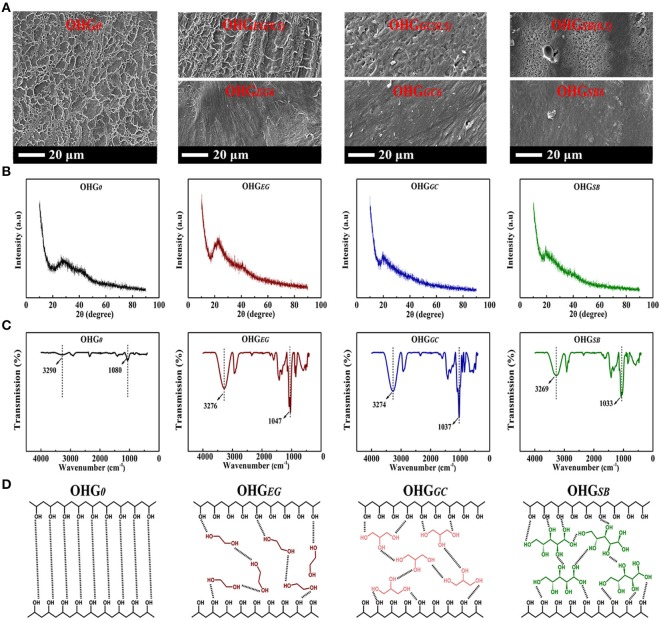
(A) SEM images of the gels [OHG0, OHGEG(0.5), OHGGC(0.5), OHGSB(0.5), OHGEG6, OHGGC6, OHGSB6], (B) XRD patterns and (C) FTIR spectra of the gels (OHG0, OHGEG6, OHGGC6, OHGSB6). For example, OHGEG(0.5) represents Eu-alginate/PVA hydrogels soaking in ethylene glycol (EG) for 0.5 h, while OHGSB6 denotes the hydrogels soaking in d-sorbitol (SB) for 6 h. (D) Schematic illustrations of the hydrogen bonds (black dotted line) between PVA polymer chains in hydrogel (OHG0), and EG, GC, SB molecules bridged PVA chains via forming hydrogen bonds in the corresponding organohydrogels.